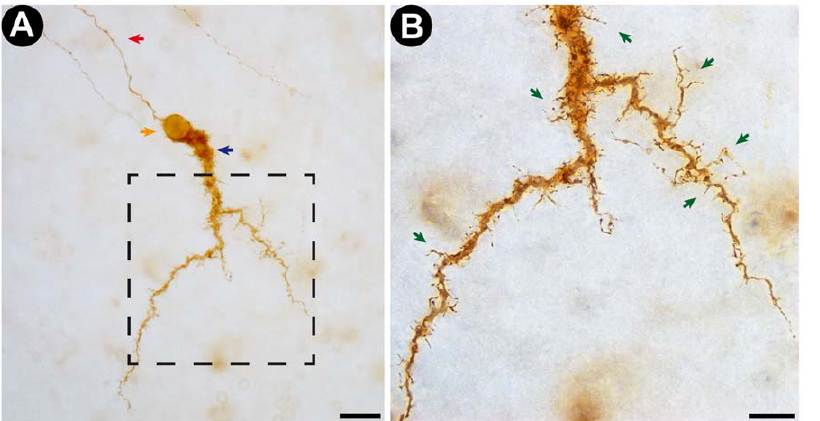
Figure 3. Representative photomicrograph of a Cajal-Retzius cell stained by the new photooxidation method. A: Low magnification (40 6 objective lens) photomicrograph of the DAB-stained Cajal-Retzius Cell obtained from a transverse section of developing rat neocortex. Note that the cell is stained over its entire volume, with no variations in staining intensity. The red arrow points at the cell’s axon. The blue arrow indicates the large horizontal dendrite that defines the Cajal-Retzius cell type. The orange arrow points at the cell’s soma Scale bar corresponds to 20 m m. B: High magnification (100 6 objective lens) photomicrograph of the insert indicated in A (dotted line square). Note the successful staining of dendritic shafts and spine-like appendages (green arrows), highlighting the high degree of detail and acuity of the staining. Scale bar corresponds to 10 m m.